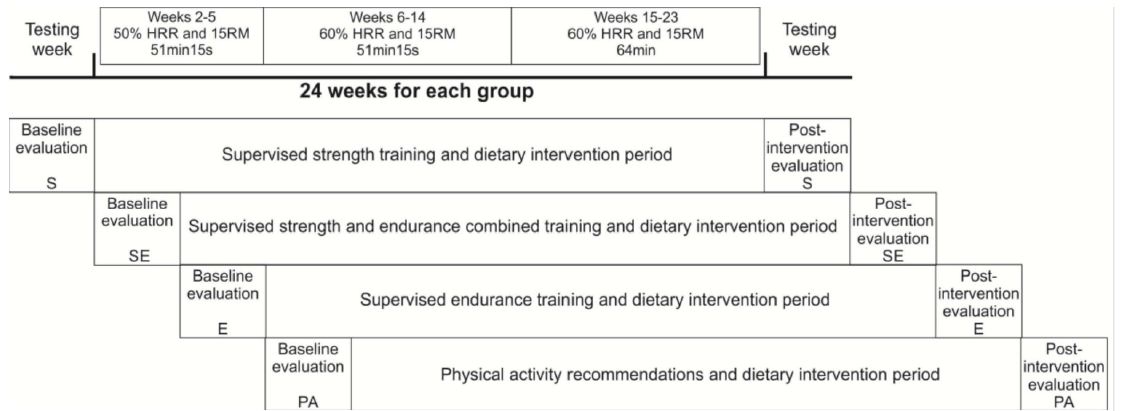
Figure 1. Time line of the Study. HRR: heart rate reserve; RM: repetition maximum; S: strength training group; E: endurance training group; SE: combined strength plus endurance training group; PA: physical activity recommendations group.